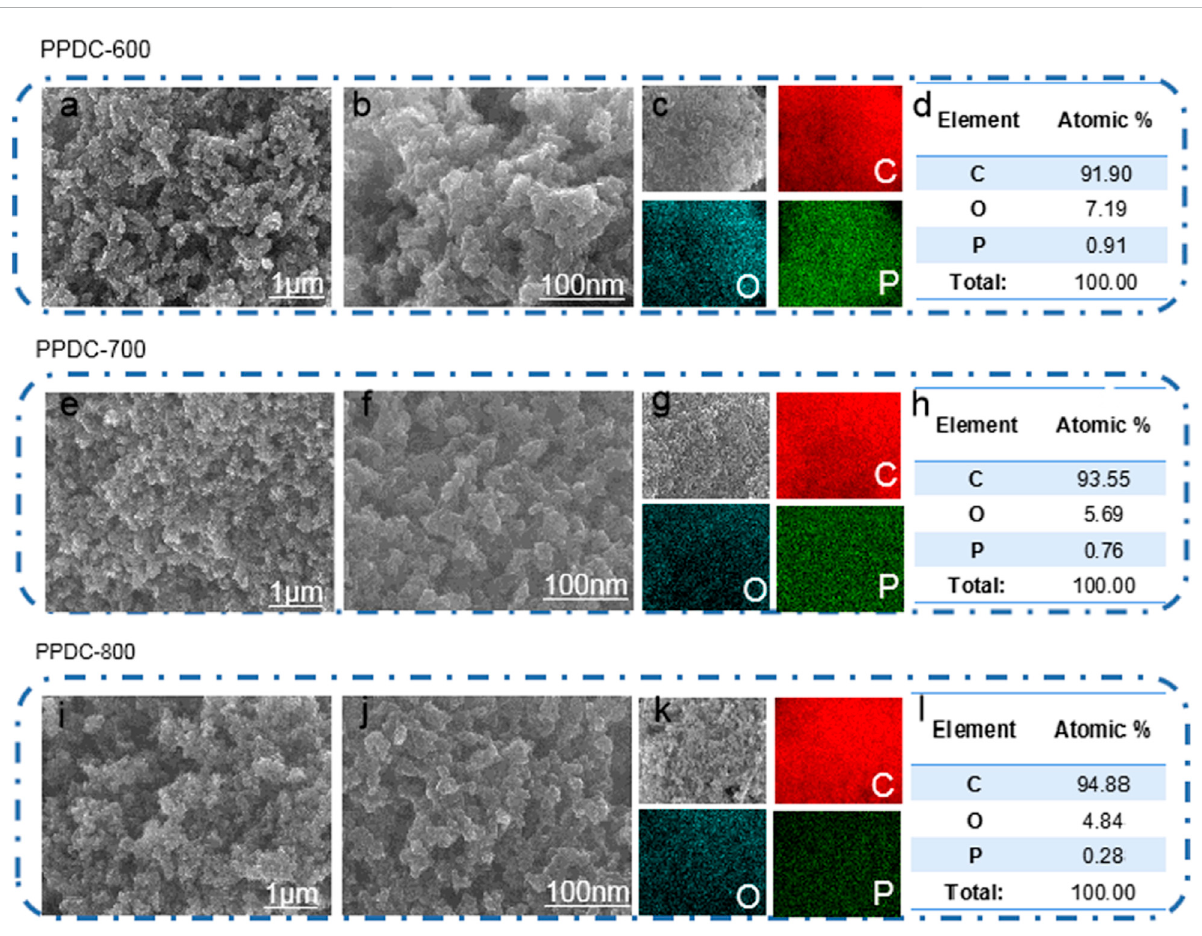
FIGURE 1 Morphological and structural characterizations. (A,B) SEM images of PPDC-600 electrode at different magni fi cations; (C) Element mapping of C, O and P for PPDC-600; (D) Element content statistics of PPDC-600; (E,F) SEM images of PPDC-700 electrode at different magni fi cations; (G) Element mapping of C, O and P for PPDC-700; (H) Element content statistics of PPDC-700; (I,J) SEM images of PPDC-800 electrode at different magni fi cations; (K) Element mapping of C, O and P for PPDC-800; (L) Element content statistics of